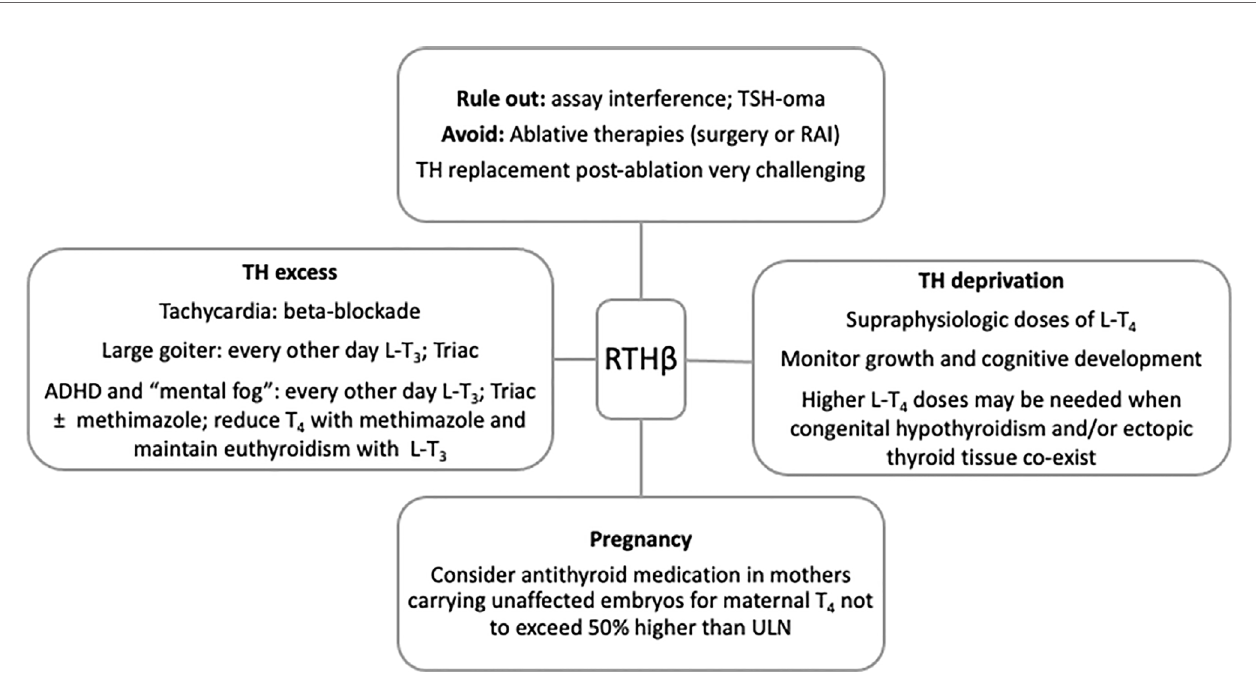
FIGURE 1 | Summary of recommendations to guide clinical management of RTH b . RAI, radioactive iodine; ADHD, attention de fi cit and hyperactivity disorder; TH, thyroid hormones; ULN, upper limit of